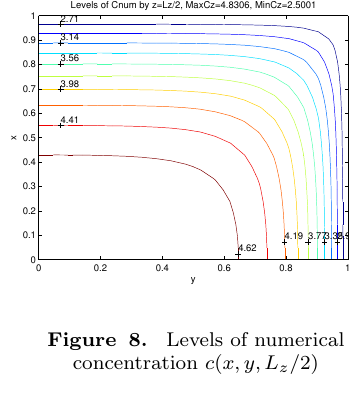
Figure 8. Levels of numerical concentration c ( x,y,L z /